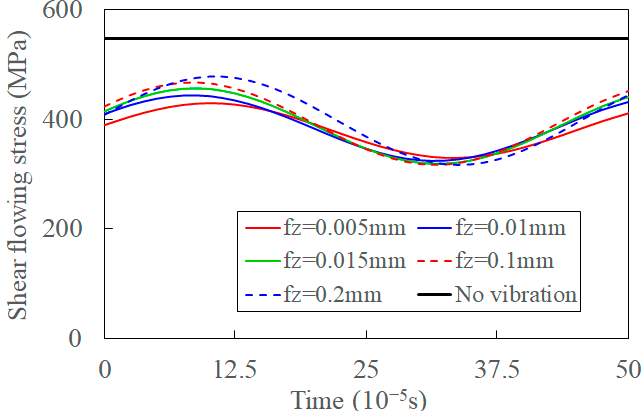
Figure 16. The shear flowing stress with increase of feed rate in UVC.